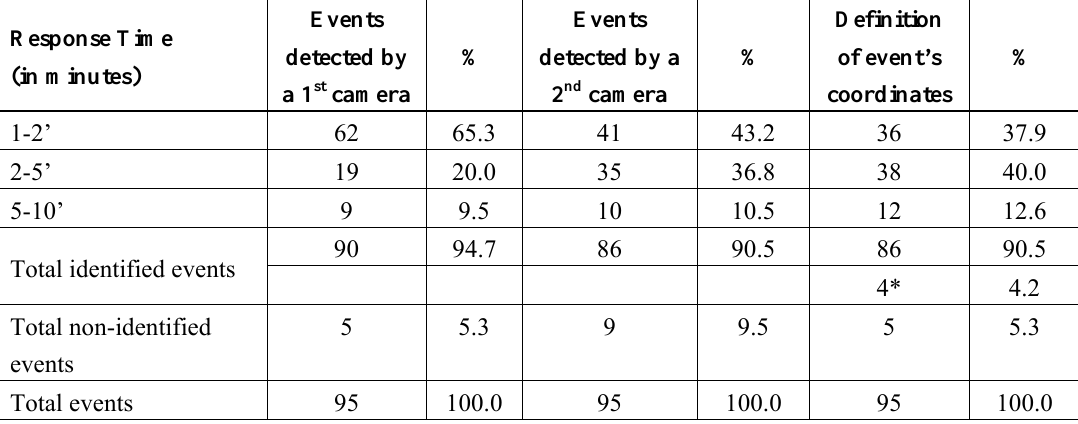
Table 2. Detection of artificial fire events from a first and second in situ camera and definition of its coordinates by response time